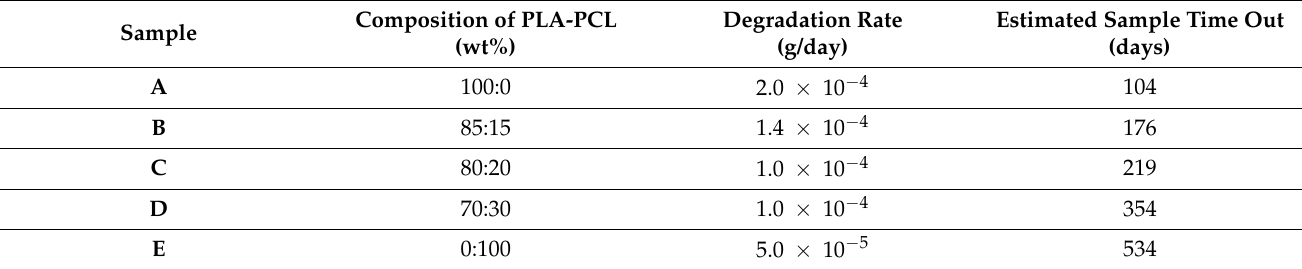
Table 4. Data of estimated time for sample to totally degrade.